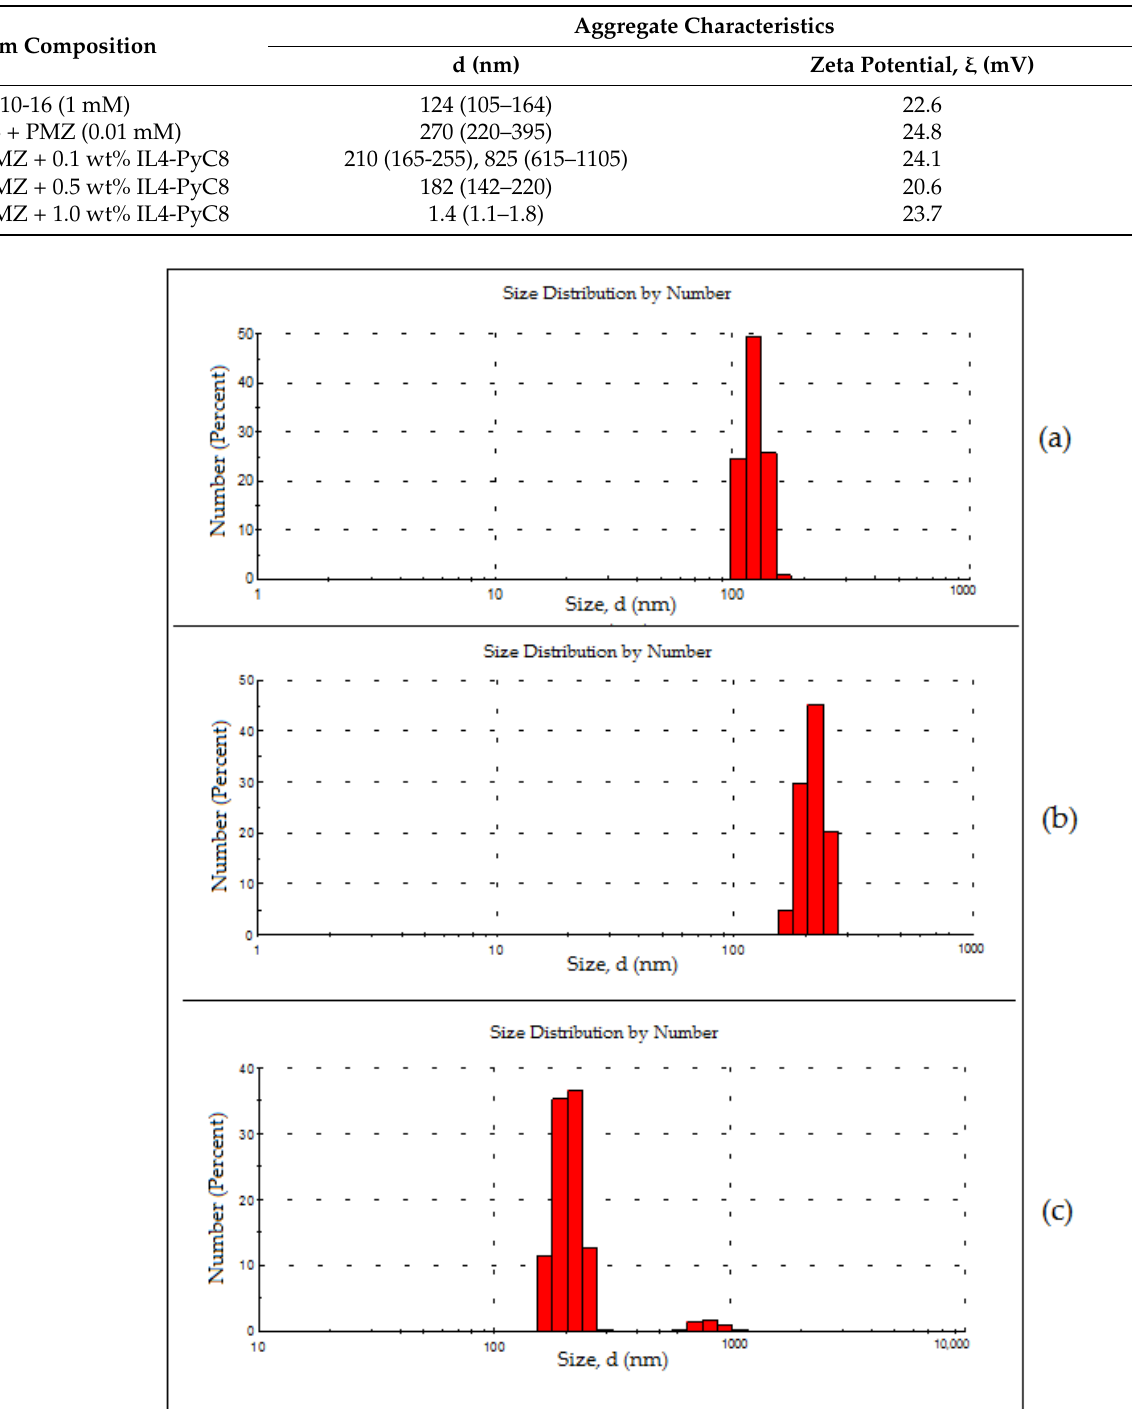
Table 6. Micellar size d (nm) as a size distribution by number and zeta potential in the presence of various concentrations of the IL 4-PyC8 in the drug PMZ and the gemini micellar